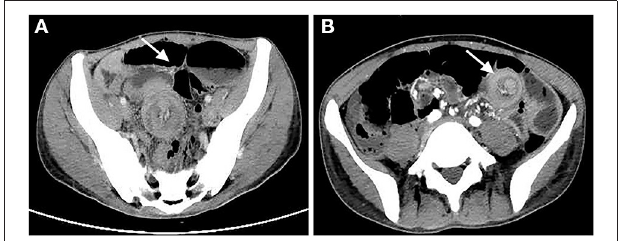
FIGURE 1 | (A) Abdominal CT scan first noticed intestinal obstruction with sign of air-fluid level instead of intussusception. (B) Transverse section of CT scan indicated intussusception with sign of “target-like” or “concentric double ring” (both are indicated by white arrow above).